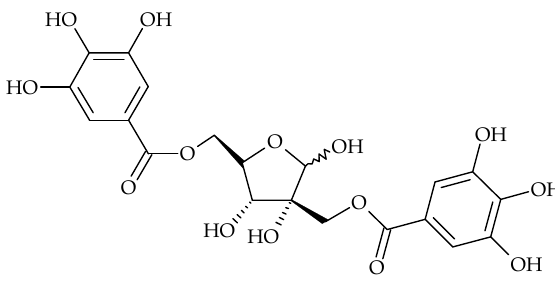
Figure 4. Chemical structure of hamamelitannin.